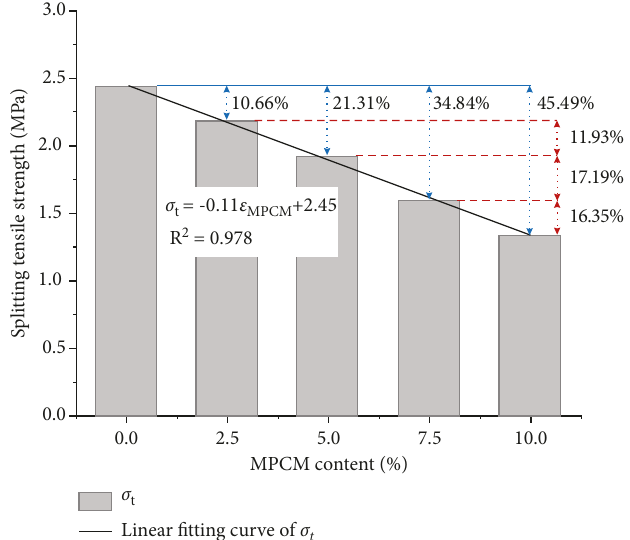
Figure 5: The relation curve between splitting tensile strength and MPCM content.